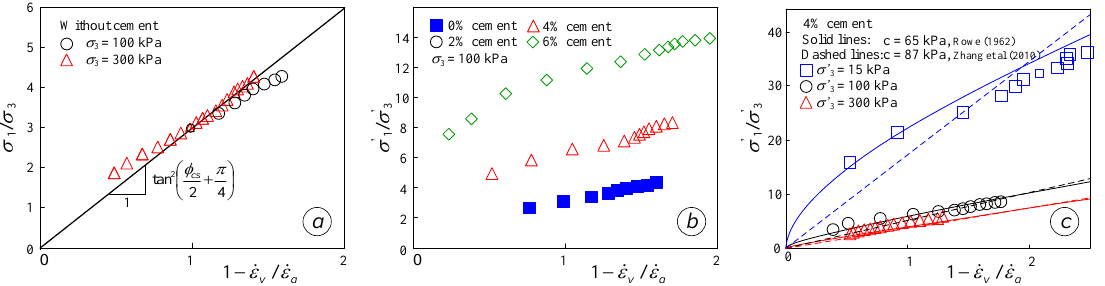
Figure 2. Stress-dilatancy representation of cemented sand [36]: ( a ) without cement, ( b ) with different cement content, and ( c ) with 4% cement content at different confining